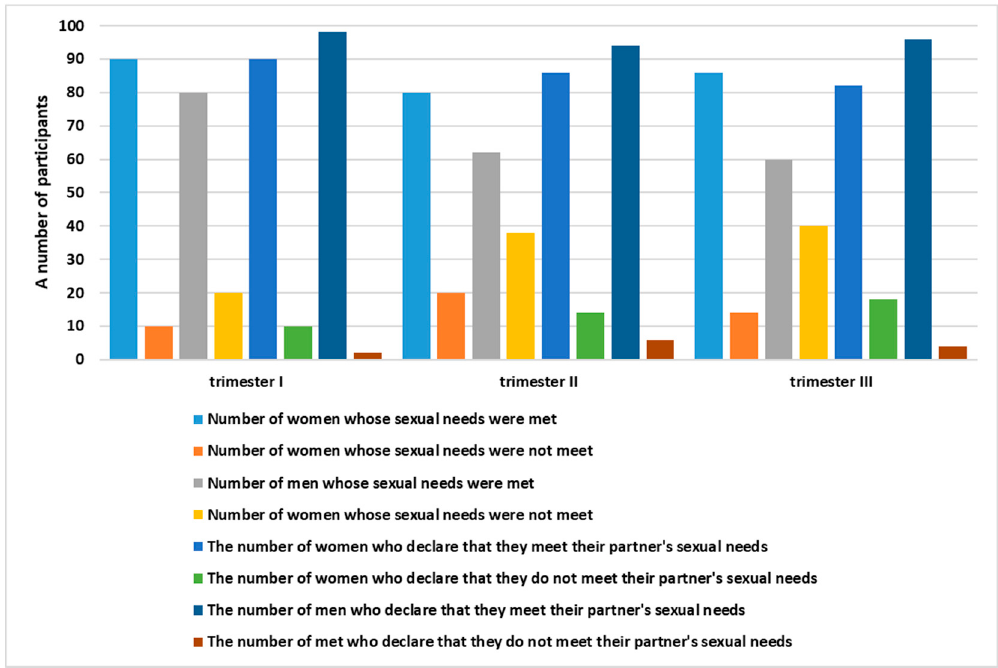
Figure 4. Satisfaction of sexual needs during the course of pregnancy.